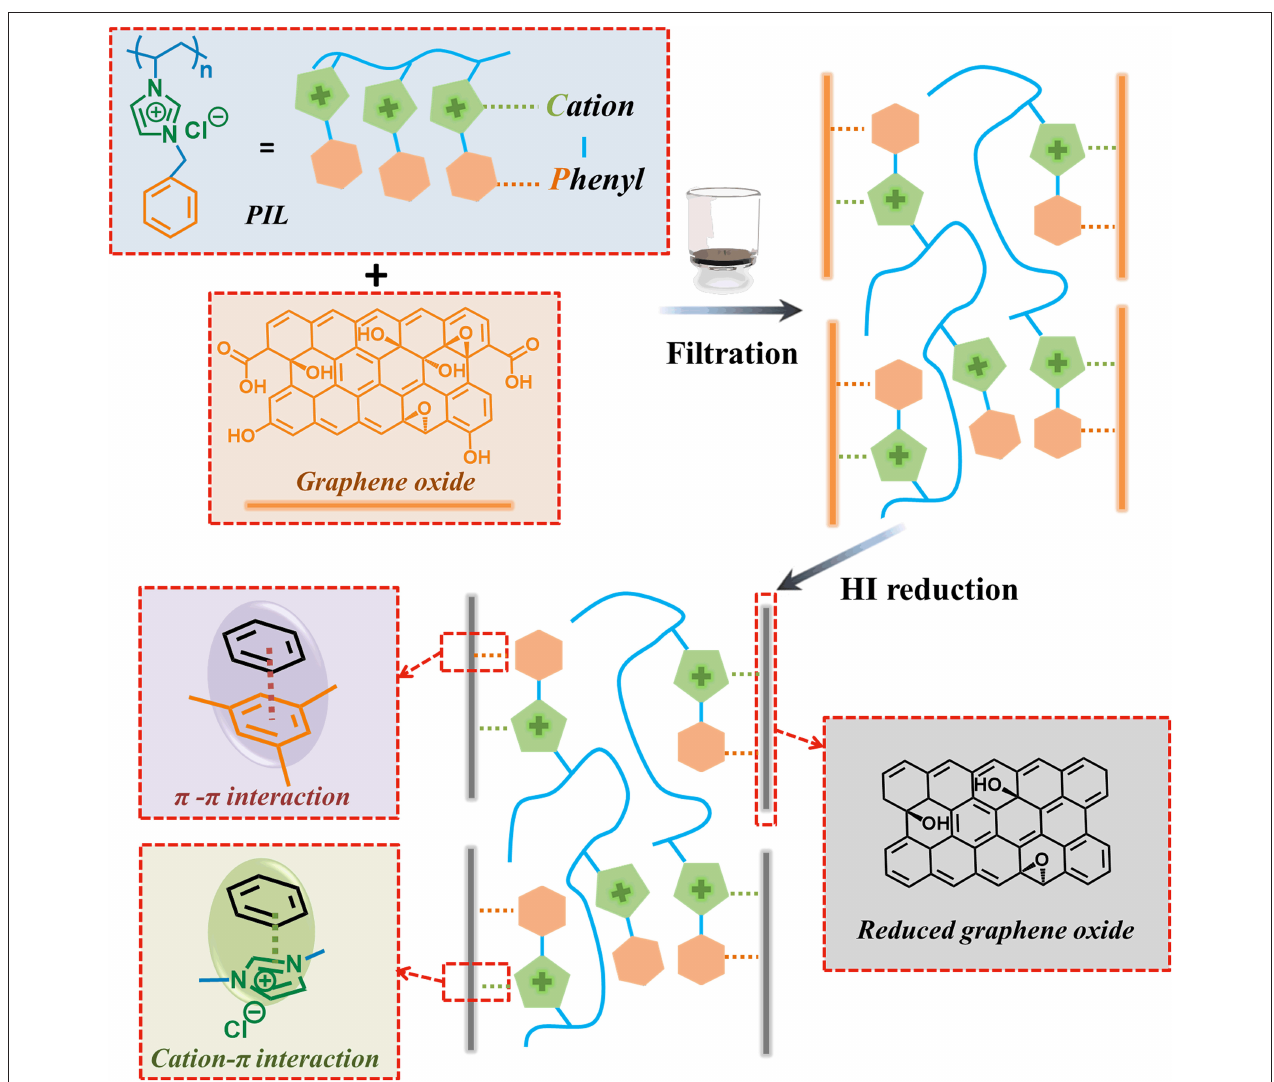
FIGURE 1 | Schematic illustration of the preparation procedure of the target rGO/PIL nanocomposite film and relevant interface interactions in it. rGO, reduced graphene oxide; PIL, poly(1-benzyl-3-vinylimidazolium